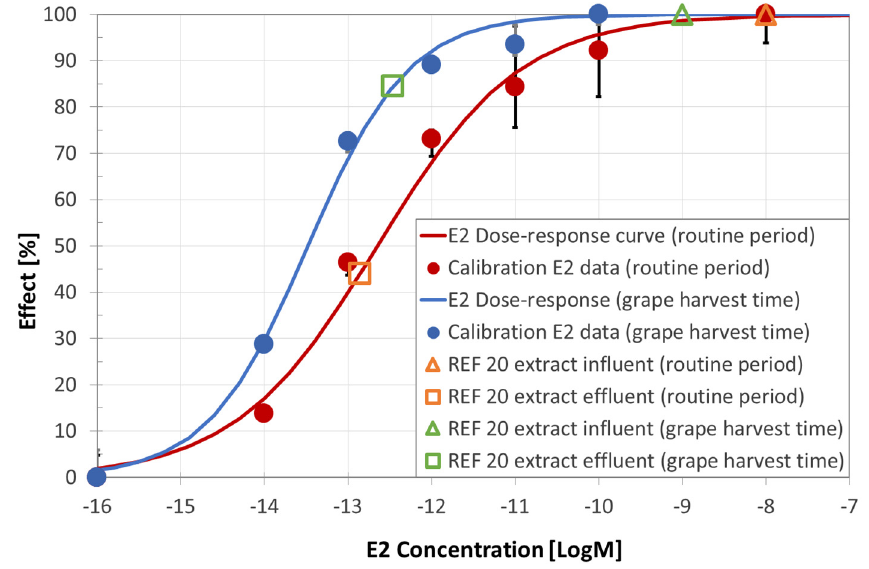
Figure 7. Estrogenic activity was assessed on MCF-7 mammary cells exposed to different concentrations of E2 and compared with REF 20 samples of influent and effluent wastewater of each campaign. The assay was conducted in triplicate: error bars show maximum and minimum values.